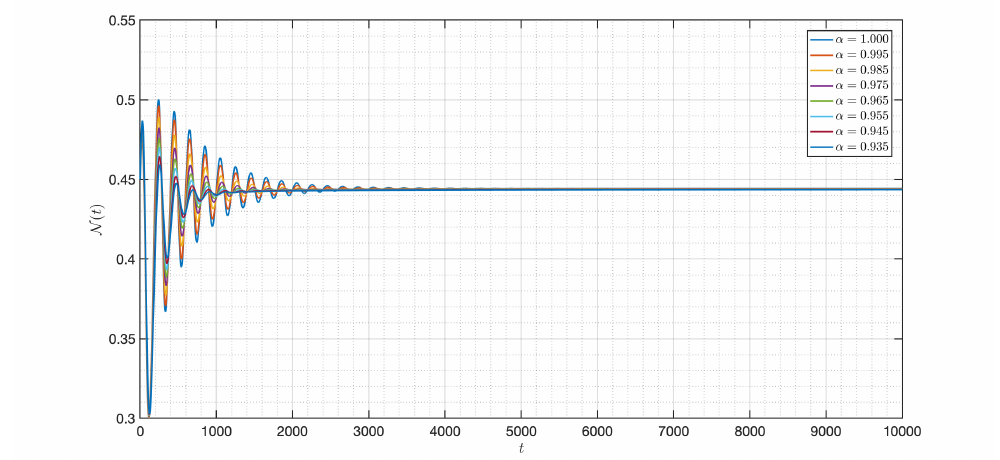
Figure 24. Dynamic of N ( t ) the model (3) for different parameters in Case III .